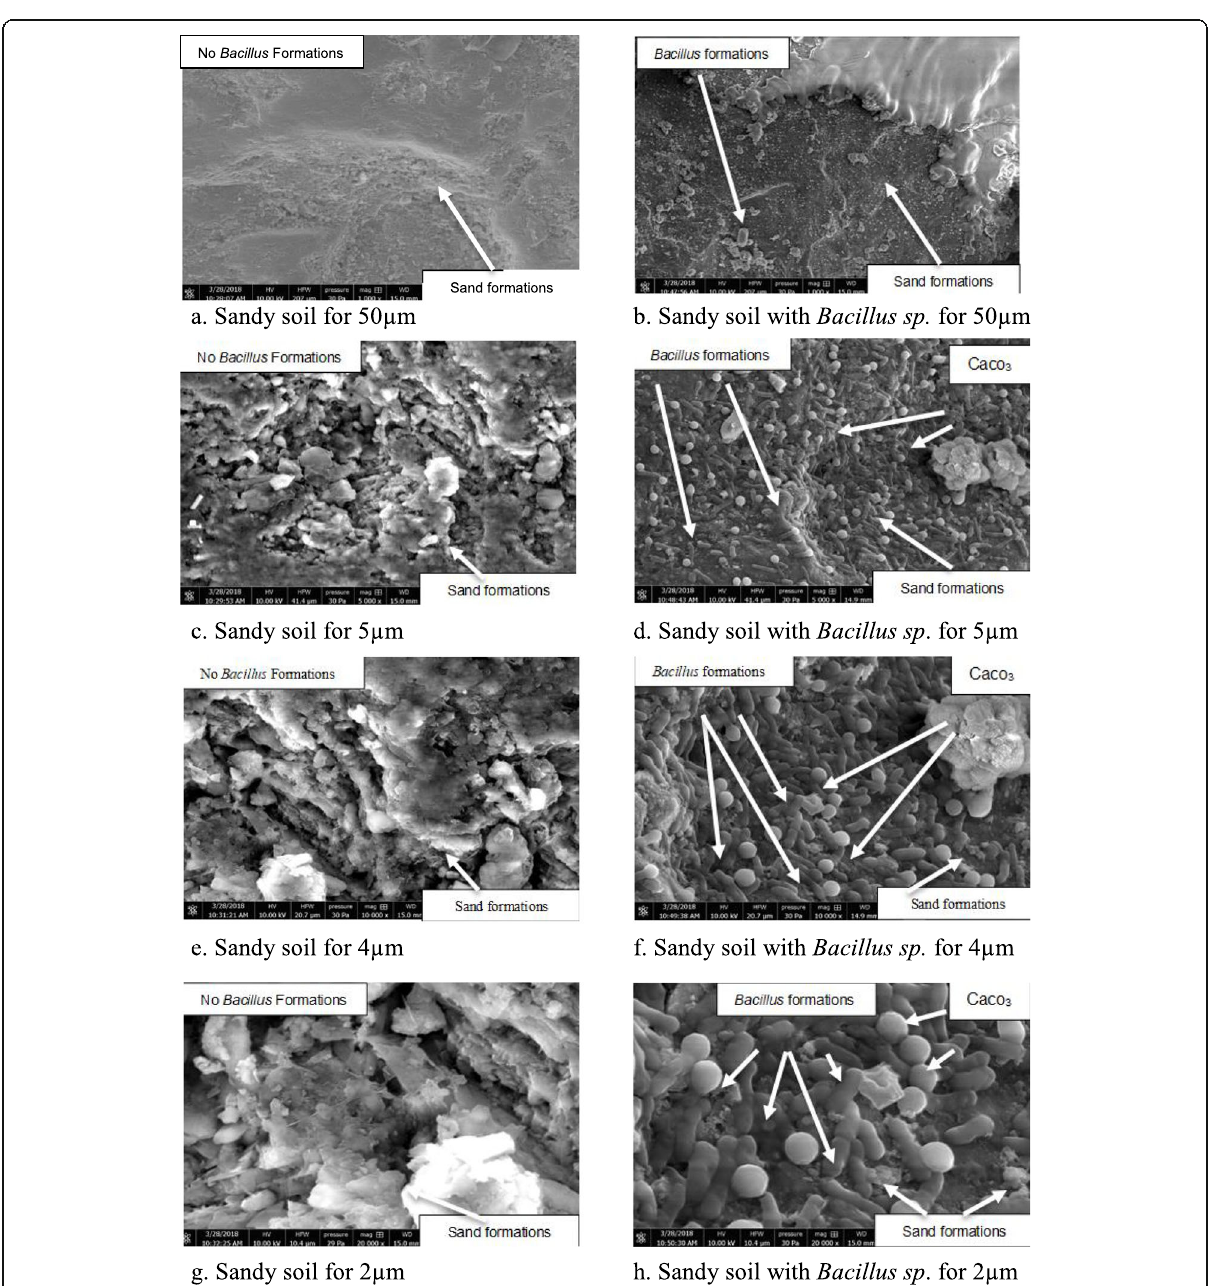
Fig. 7 The images of SEM before stabilization ( a , c , e , g ) and after stabilization ( b , d , f , h ) (Bagriacik et al.,